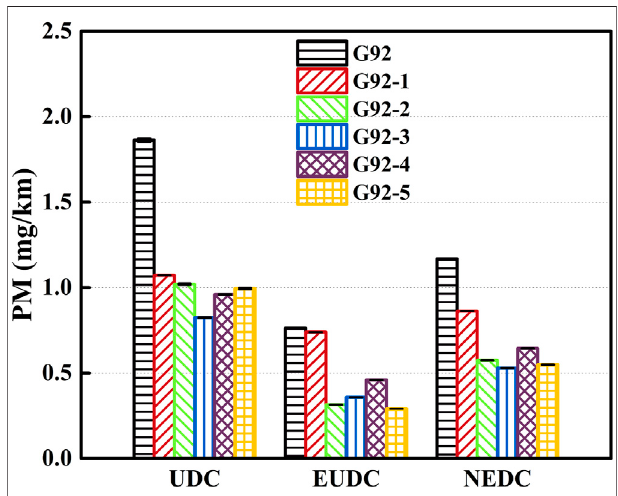
FIGURE 8 | Effects of different additives on PM emissions of the